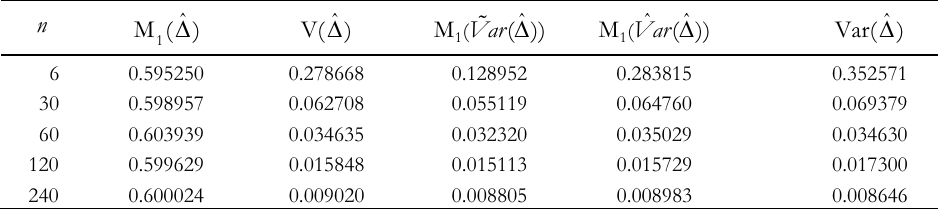
Simulation data for the estimation of ˆ Var( ) (cid:39) by and